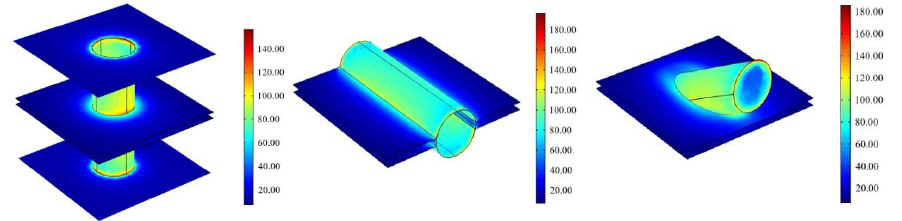
Figure 8. The von Mises stress around the borehole wall for different well types and water con- tents.